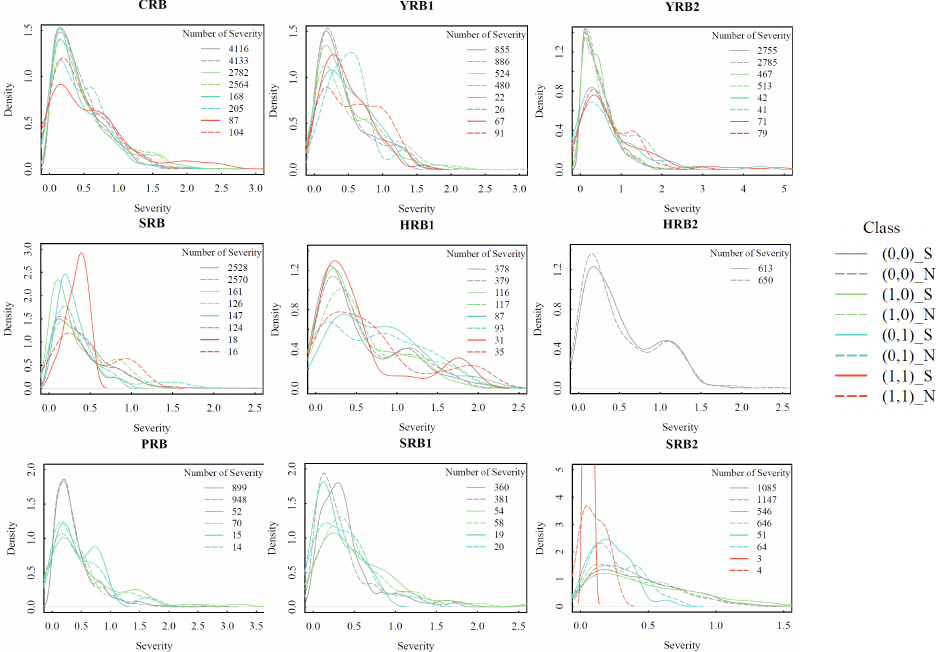
Figure 9. Probability density of severity estimated by SPEI and NSPEI in the nine river basins of China under different classifications of ( µ , σ ) changes in the fall–winter